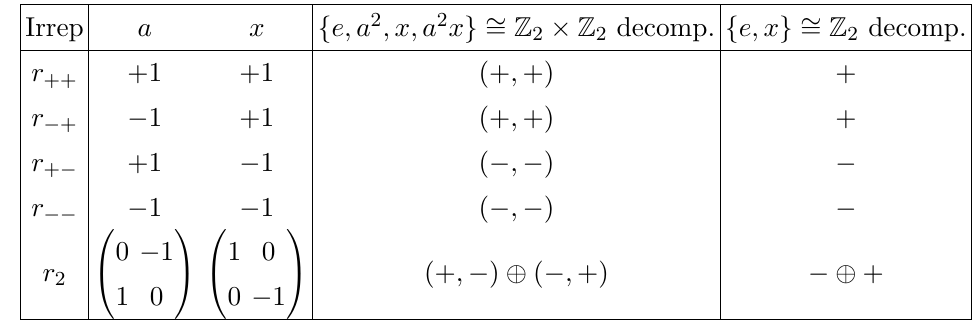
Table 2 . The irreducible representations of D 8 , and their decompositions under relevant